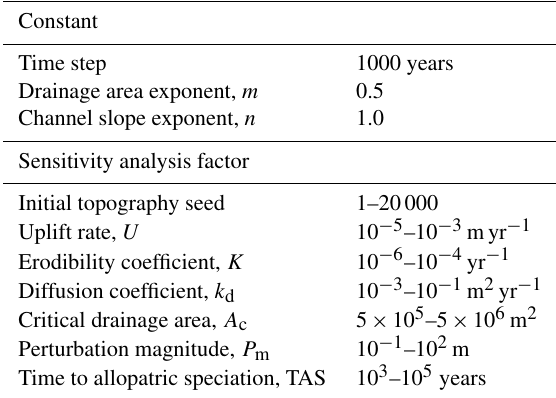
Table 1. Parameters of model